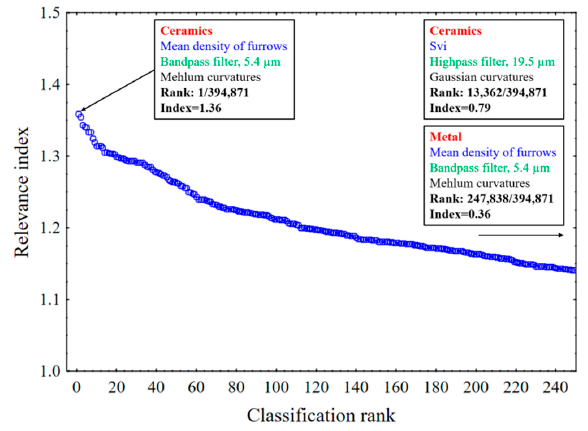
Figure 10. Classification rankings by relevance indices for discrimination of the seven materials by 75 topographic parameters for 100 bootstraps.